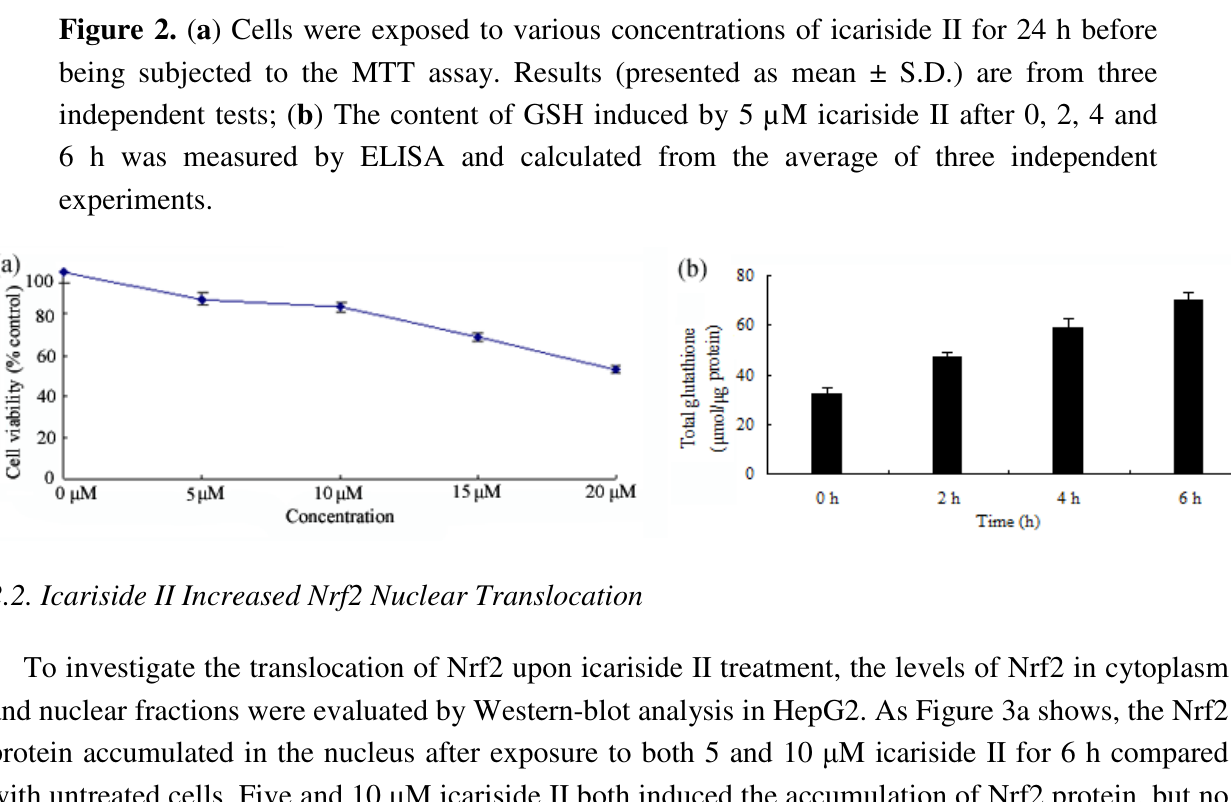
Figure 3. Icariside II stimulates Nrf2 nuclear translocation. Nuclear and